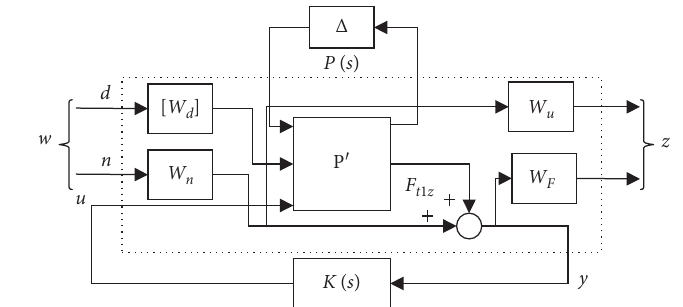
Figure 19: The closed-loop system [110].